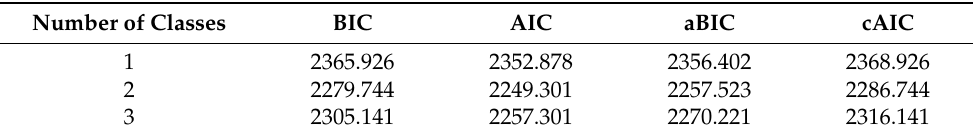
Table 2. Indicators of it for models with one through three latent classes.